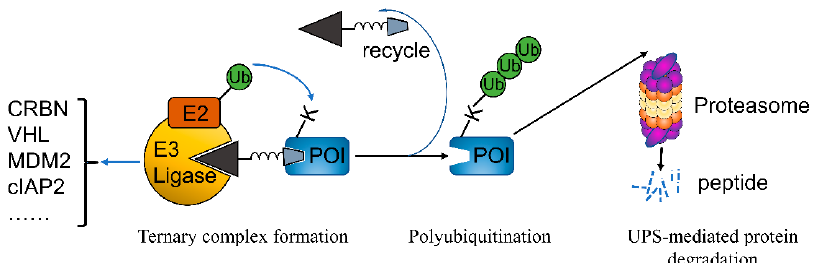
Figure 5. Mode of protein degradation using PROTACs. PROTACs bring the protein of interest (POI) in the vicinity of E3 ligase (such as CRNB, VHL, MDM2, cIAP2, etc.), forming a stable ternary complex of POI-PROTAC-E3 ligase. This structure facilitates ubiquitin transfer from E2 conjugating enzyme to a lysine residue in POI, resulting in ubiquitination of POI. Ubiquitination can occur on ubiquitin itself, leading to polyubiquitination. Polyubiquitinated POI is then subjected to proteasome for degradation via ubiquitin proteasome system (UPS). PROTAC degrader can be recycled for the next round of degradation.